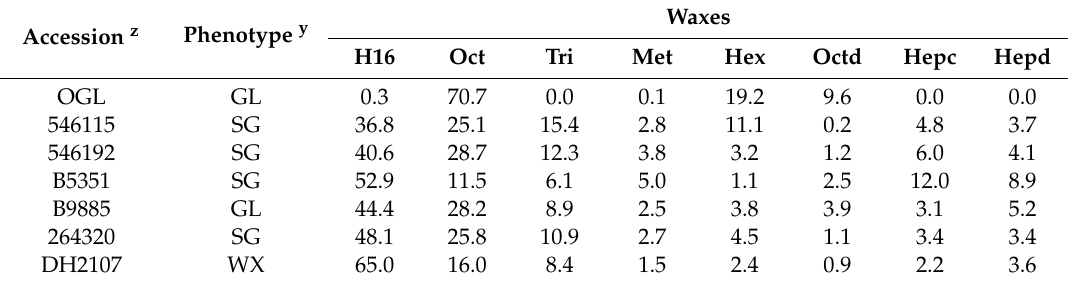
z Origin of accessions listed in Table 1. y Waxes are hentriacontanone-16 (H16), octacosanol-1 (Oct), triacontanol-1 (Tri), 2-methyloctacosane (Met), hexacosanol-1 (Hex), 1-ethenyloxy octadecane (Octd), heptacosane (Hepc), and